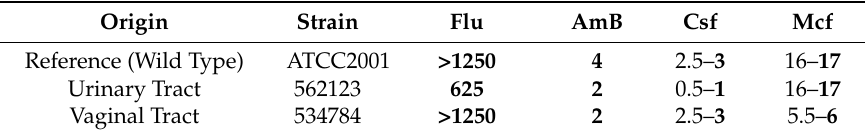
Table 1. Minimum biofilm eradicatory concentrations (MBEC) for the Candida glabrata strains